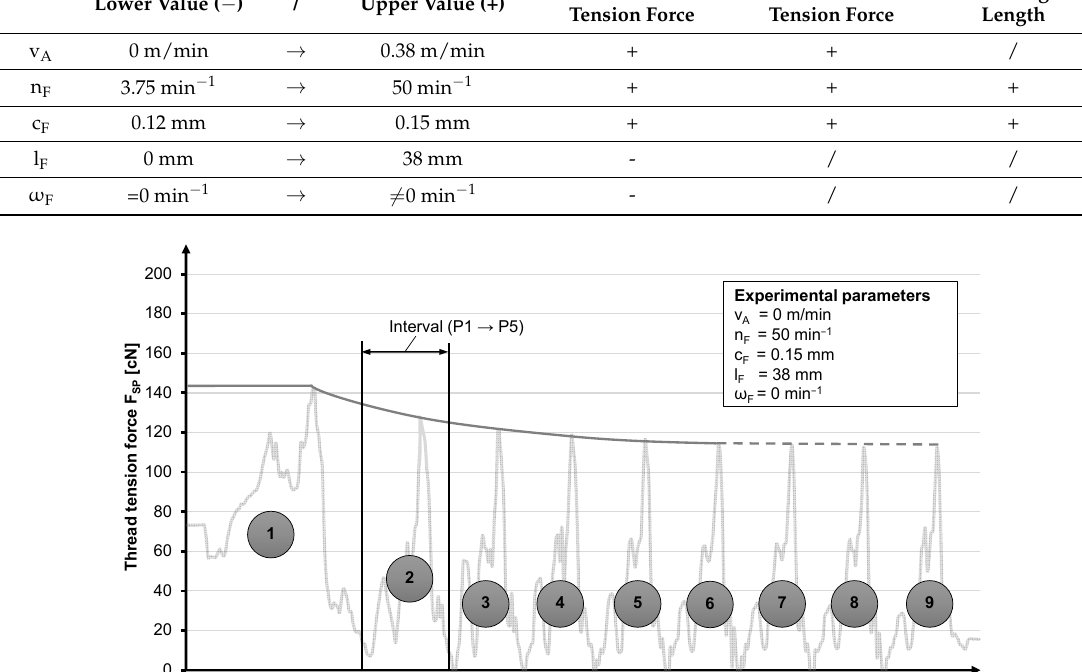
Figure 8. Settling time of a bobbin with a horn gear speed of 50 min − 1 . Table 2. Characteristics and the effect of the variables of the factor test space.